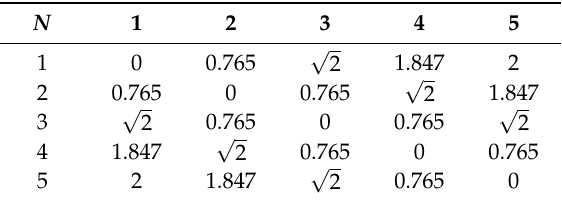
Table 2. Distance Matrix for the 5-PolSK Bands